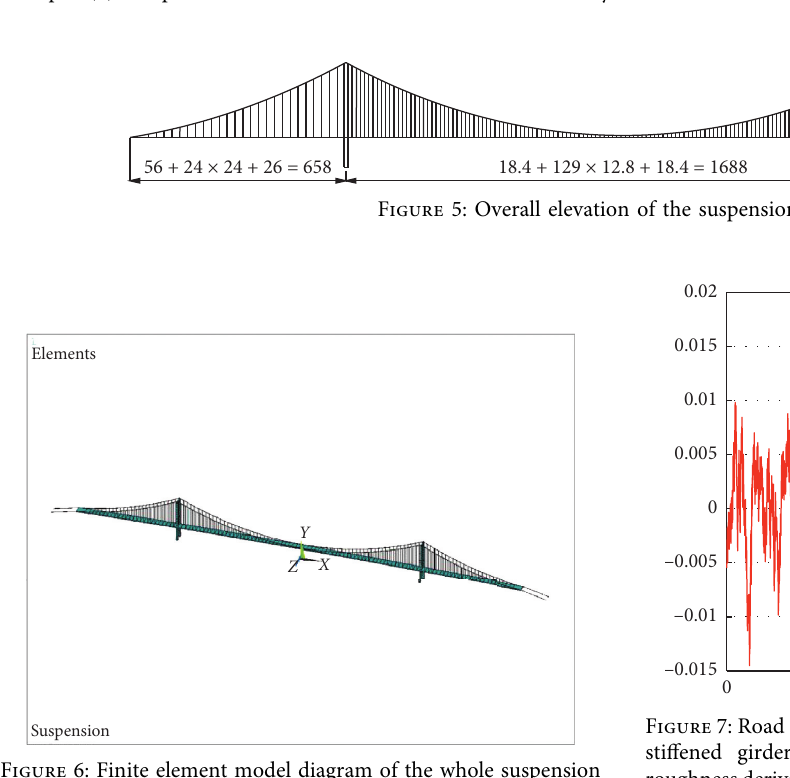
Figure 4: Time-history response of the vertical displacement of the midspan joint; (a) finite element time-history response of the numerical example; (b) comparison between BP neural network time-history results and finite element time-history results.